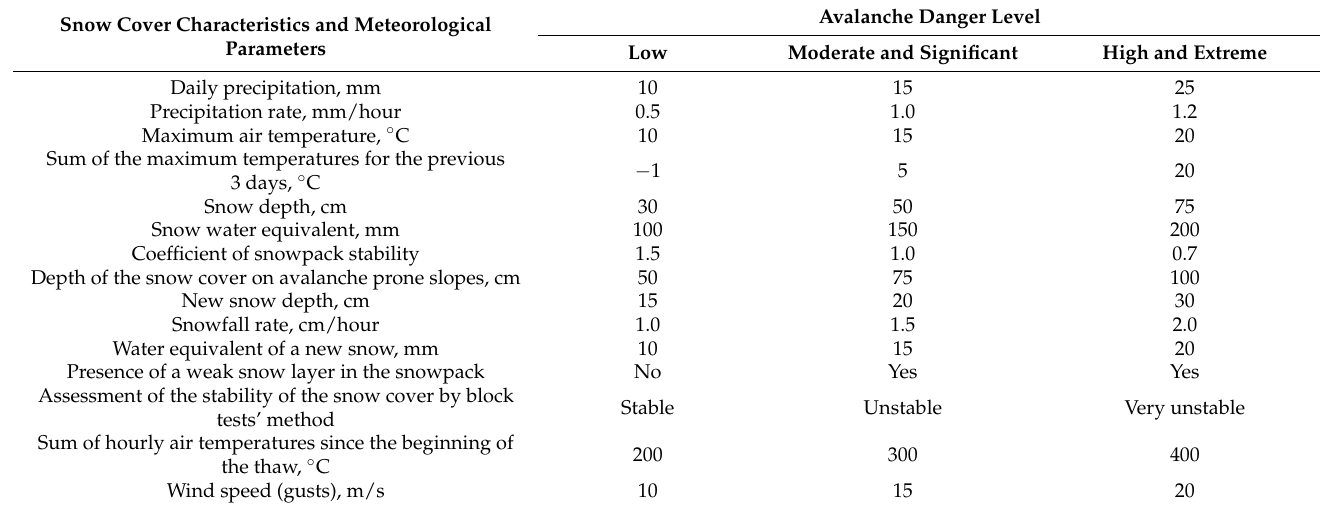
Table 5. Threshold values of the snow cover characteristics and meteorological parameters for different avalanche danger